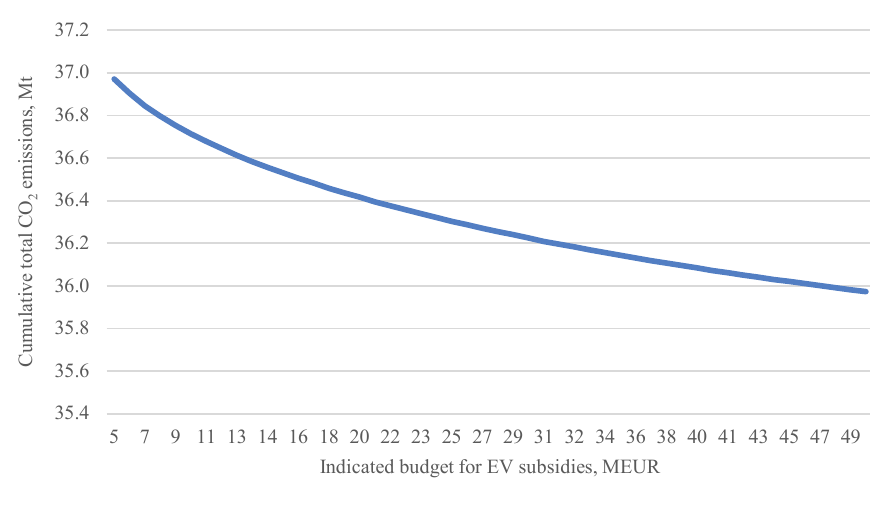
Fig. 8. Cumulative total CO 2 emissions depending on the indicated budget for EV subsidies.